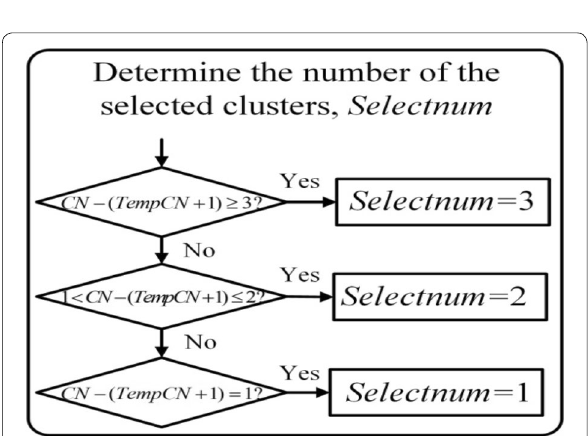
Figure 9 Flow chart of automatically determining the number of candidate clusters for each identification